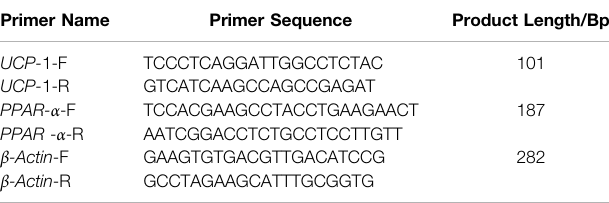
TABLE 1 | Real-time PCR Primer